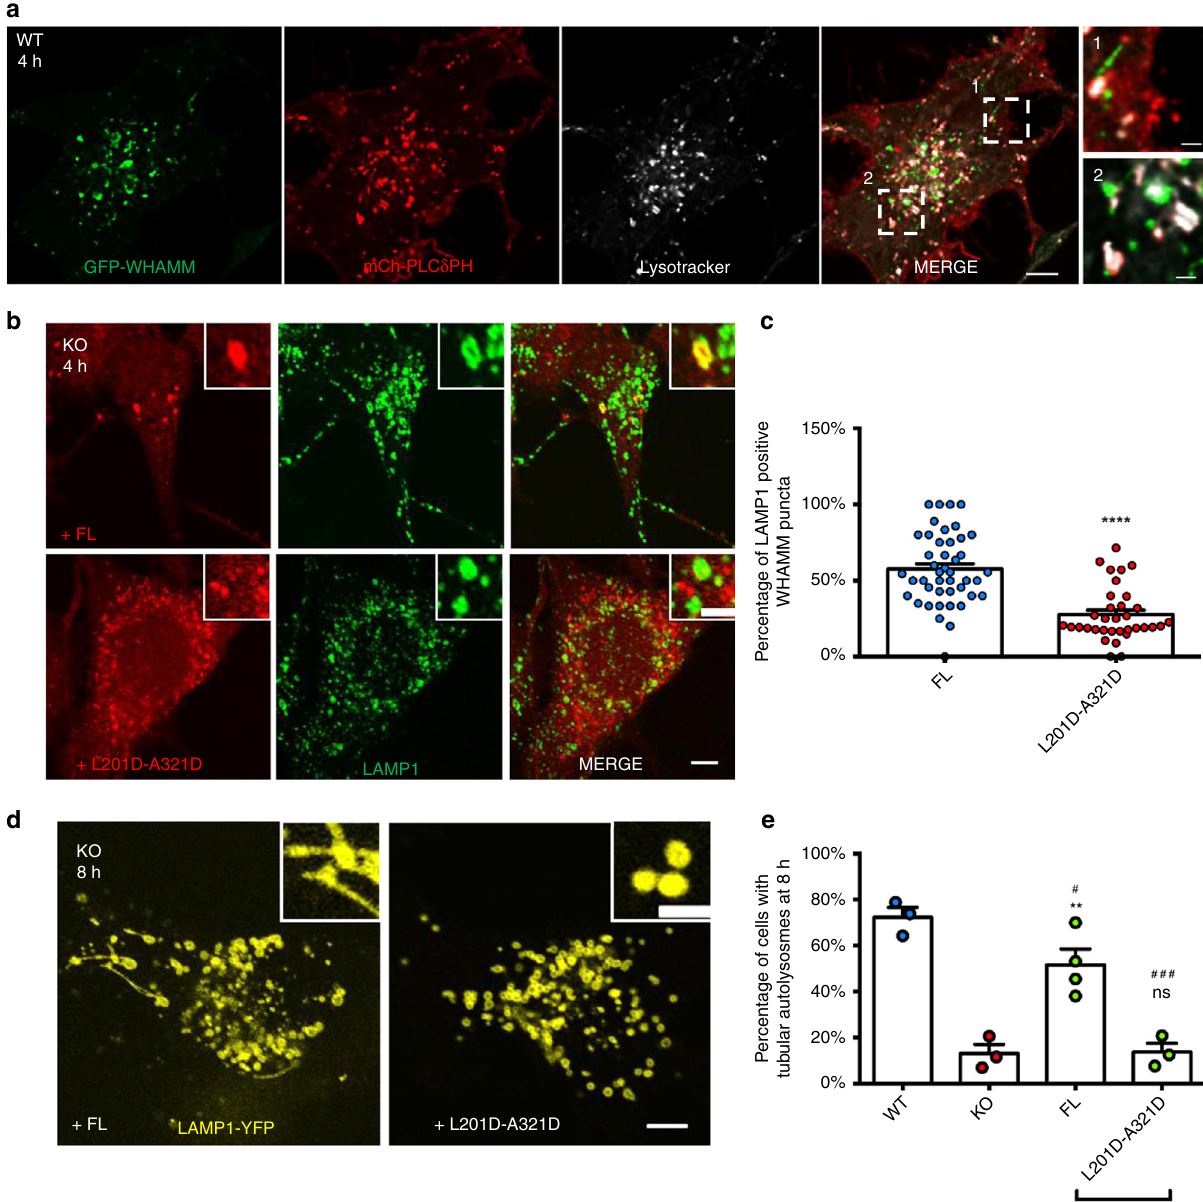
Fig. 7 WHAMM is recruited to autolysosomes through PI(4,5)P 2 . a WT NRK cells stably expressing GFP-WHAMM were transfected with mCherry-PLC δ - PH. 18 h post transfection, cells were starved for 4 h in the presence of 100 nM Lysotracker Deep Red and observed using live-cell imaging. Dashed squares showed WHAMM ’ s localization correlates to Plasma membrane (1) and autolysosomes (2). (scale bar, main Fig. 5 μ m; right panel 1 μ m) These images were deconvolved using Nikon ’ s built-in software (NIS-elements). b Constructs expressing FL WHAMM with or without the double mutation (L201D- A321D) were transfected into WHAMM-KO cells. After 18 h of transfection, cells were starved for 4 h, then fi xed and stained with antibody against LAMP1 (scale bar, main micrograph 5 μ m; upper right panel 2 μ m). c Cells in b were assessed for WHAMM-positive LAMP1 structures. n = 44 (FL) and 34 (L201D-A321D) cells from two independent experiments. Error bars indicate SEM. Two-tailed t- test; **** p < 0.0001. d WHAMM-KO cells stably expressing LAMP1-YFP were transfected with constructs containing FL WHAMM with or without the double mutation (L201D-A321D). In all, 18 h post transfection, cells were starved for 8 h, then observed by confocal microscopy (scale bar, main micrograph 5 μ m; upper right panel 2 μ m). e Cells in d were quanti fi ed for tubular autolysosomes at 8 h. In total, 103 (WT), 120 (KO), and 50 (L201D-A321D) cells were examined in n = 3 independent